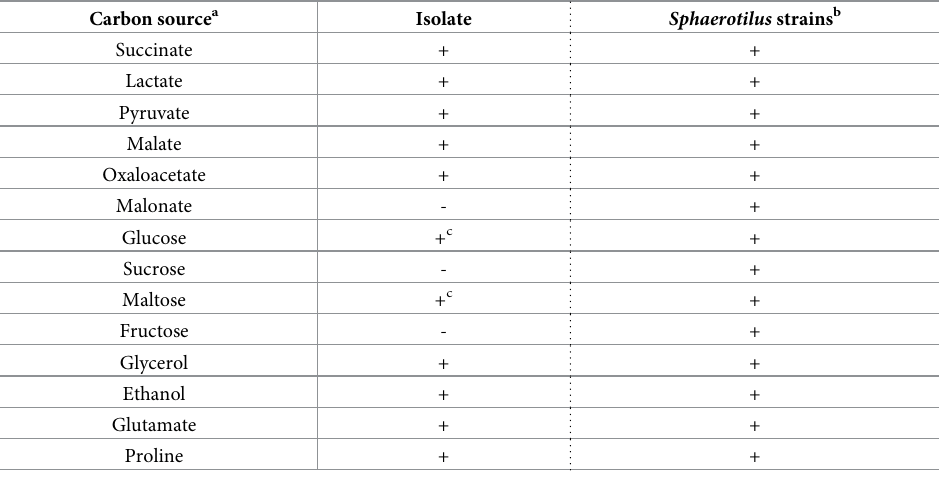
Table 1. Typical carbon compound utilization. Carbon source a Isolate Sphaerotilus strains b Succinate + + Lactate + + Pyruvate Oxaloacetate